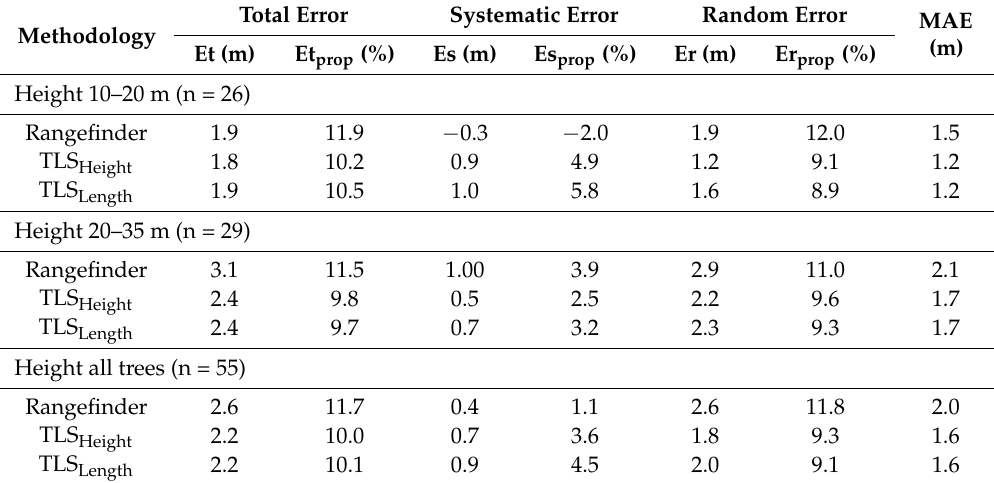
Table 2. Metrics of error among the methodologies for predict the total height (Ht) for trees with Ht between 10 and 20 m (n = 26), Ht between 20 and 35 m (n = 29), and for all trees (n = 55): The errors are presented in absolute and proportional terms for respective measurements obtained from hypsometry using the laser rangefinder (Rangefinder), as well as the extraction of height (TLS Height ) and length obtained from the TLS point-cloud (TLS Length ). The Mean Absolute Error (MAE) is the difference between the estimate and reference measurements. Total Error Systematic Methodology